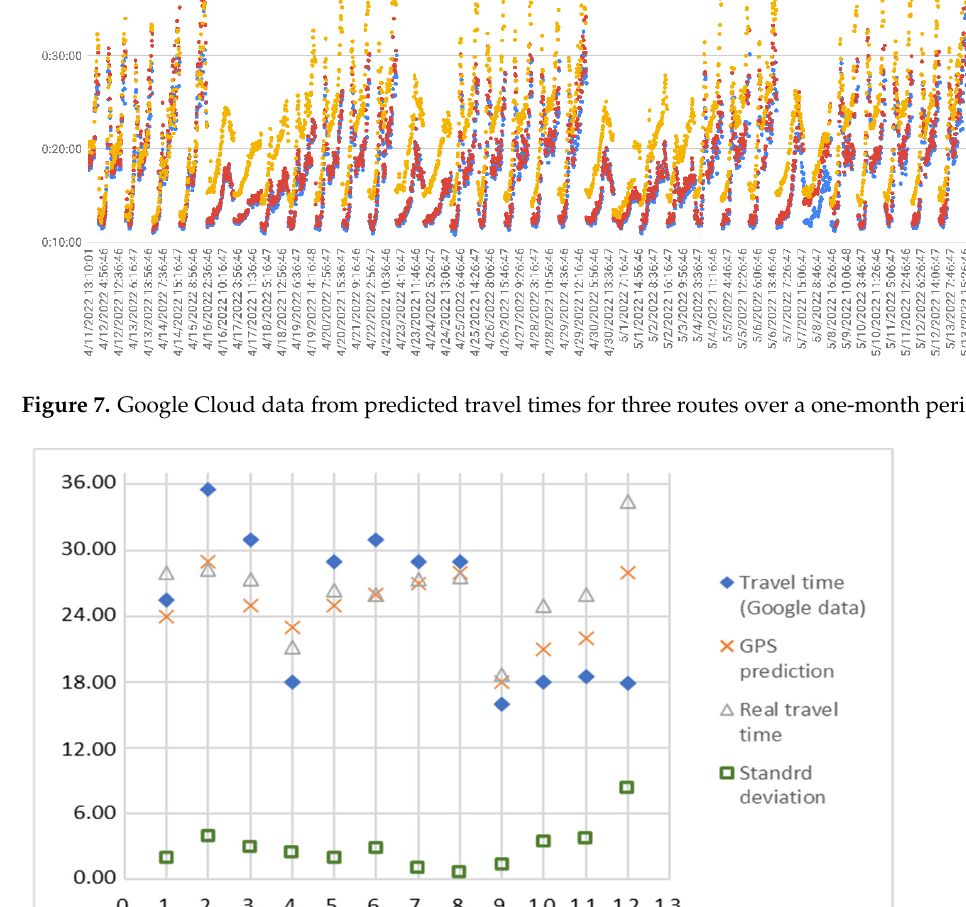
Figure 8. Comparison of heterogeneous data from different sources (Google Cloud data, UAV flight video data, GNSS data) on travel time for selected routes.